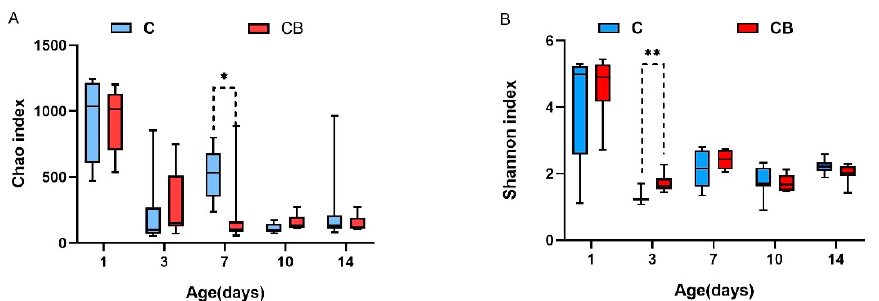
Figure 2. Alpha diversity in the cecal bacterial community of Muscovy ducks in the C and CB groups at the indicated ages. ( A ) The Chao index indicates the species richness of the cecal bacteria. ( B ) The Shannon index shows the community diversity of the cecal bacteria. Asterisks indicate statistically significant differences between the two groups. Data were expressed as the mean ± SD ( n = 8). Differences between the C and CB groups at each time point were analyzed by the unpaired two-tailed Student’s t -test. * p < 0.05, ** p < 0.01. C, control group; CB, C. butyricum group.